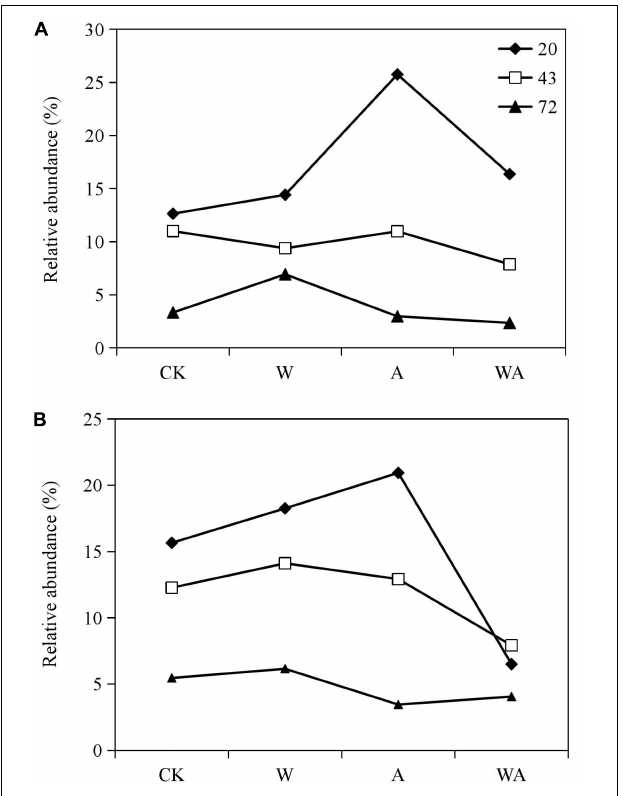
FIGURE 4 | Relative abundance of the predominant families Flavobacteriaceae (A) and Rhodobacteraceae (B) in samples from different groups in different periods. CK, control; W, warming treatment; A, acidification treatment; WA, acidification and warming treatment. 20, 43, and 72: samples were collected at 20, 43, and 72